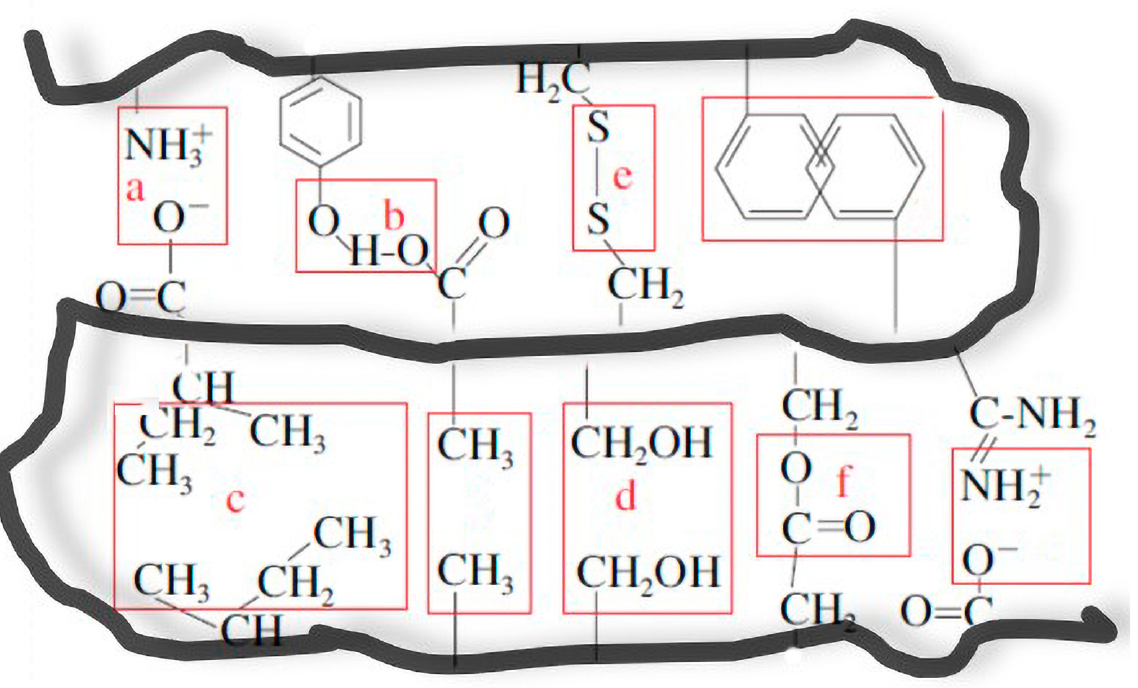
Figure 5. Protein molecular structure and chemical bonds: ( a ) ionic bonds; ( b ) hydrogen bonds; ( c ) hydrophobic bonds; ( d ) van der Waals forces; ( e ) disulfide bonds; ( f ) ester bonds.